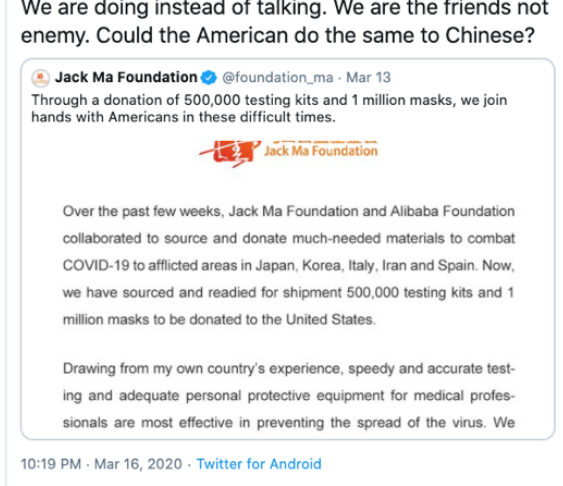
Figure 6. Screenshot of @ChineseEmbSA’s tweet. Source: Chinese Embassy in South Africa